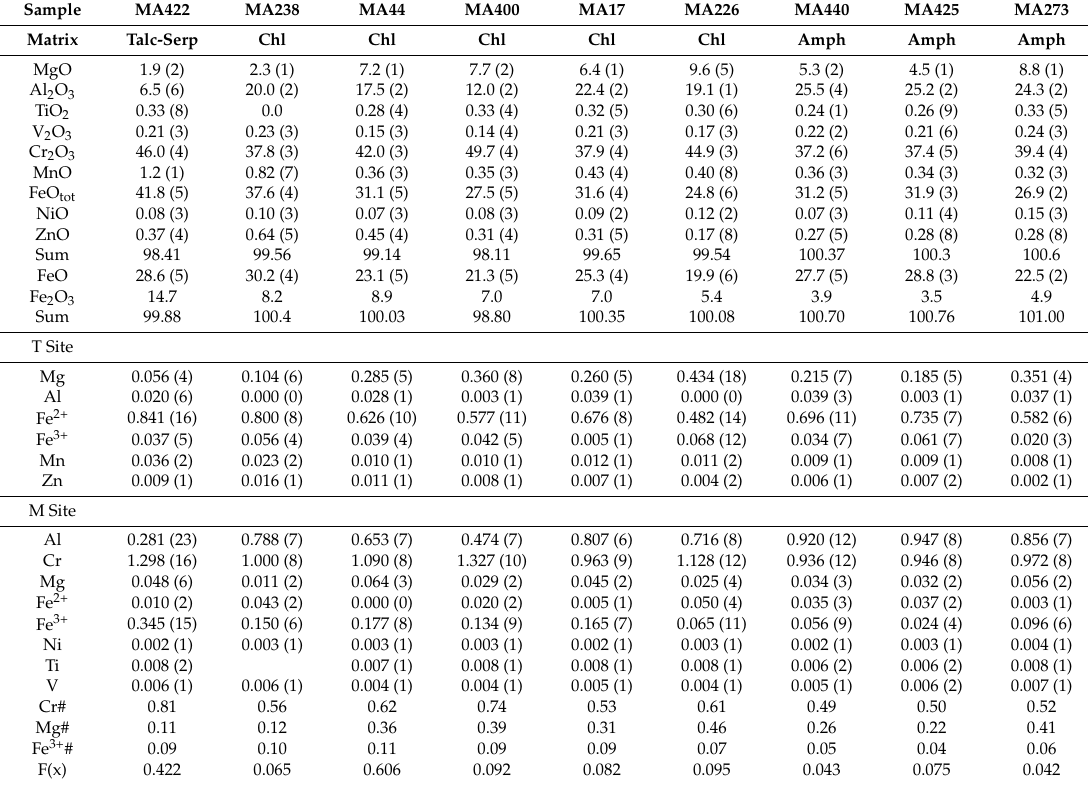
Table 2. Mean chemical analyses (10–15 spot analyses for each crystal) and cation distribution in T and M sites of the analysed Cr-spinels, on the basis of four oxygen atoms per formula unit.